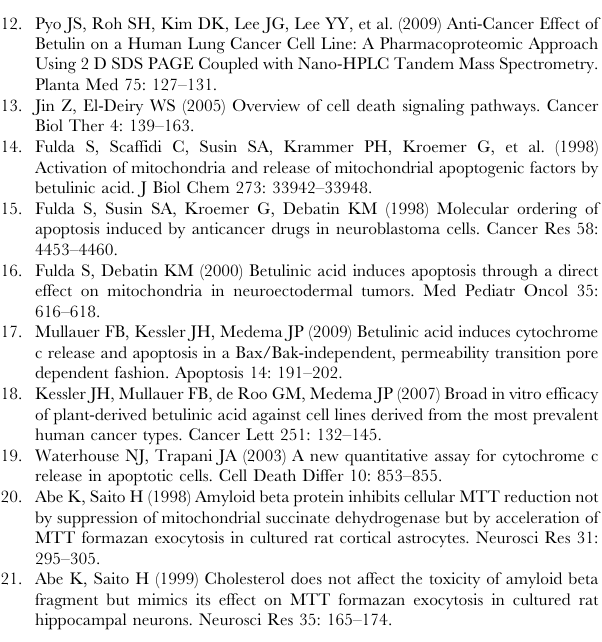
Figure S1 MTT conversion. Effects of BetA, cholesterol and BE on MTT assay: Jurkat cells were treated as indicated, incubated with MTT reagent and photographed under a phase-contrast microscope. Found at: doi:10.1371/journal.pone.0005361.s001 (6.51 MB